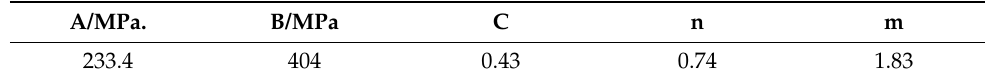
Figure 6. σ y − ln ˙ ε ∗ Fitting relationship. Figure 6. 𝜎 𝑦 − 𝑙𝑛𝜀̇ ∗ Fitting relationship. Table 4. J-C constitutive model Table 4. J-C constitutive model parameters.